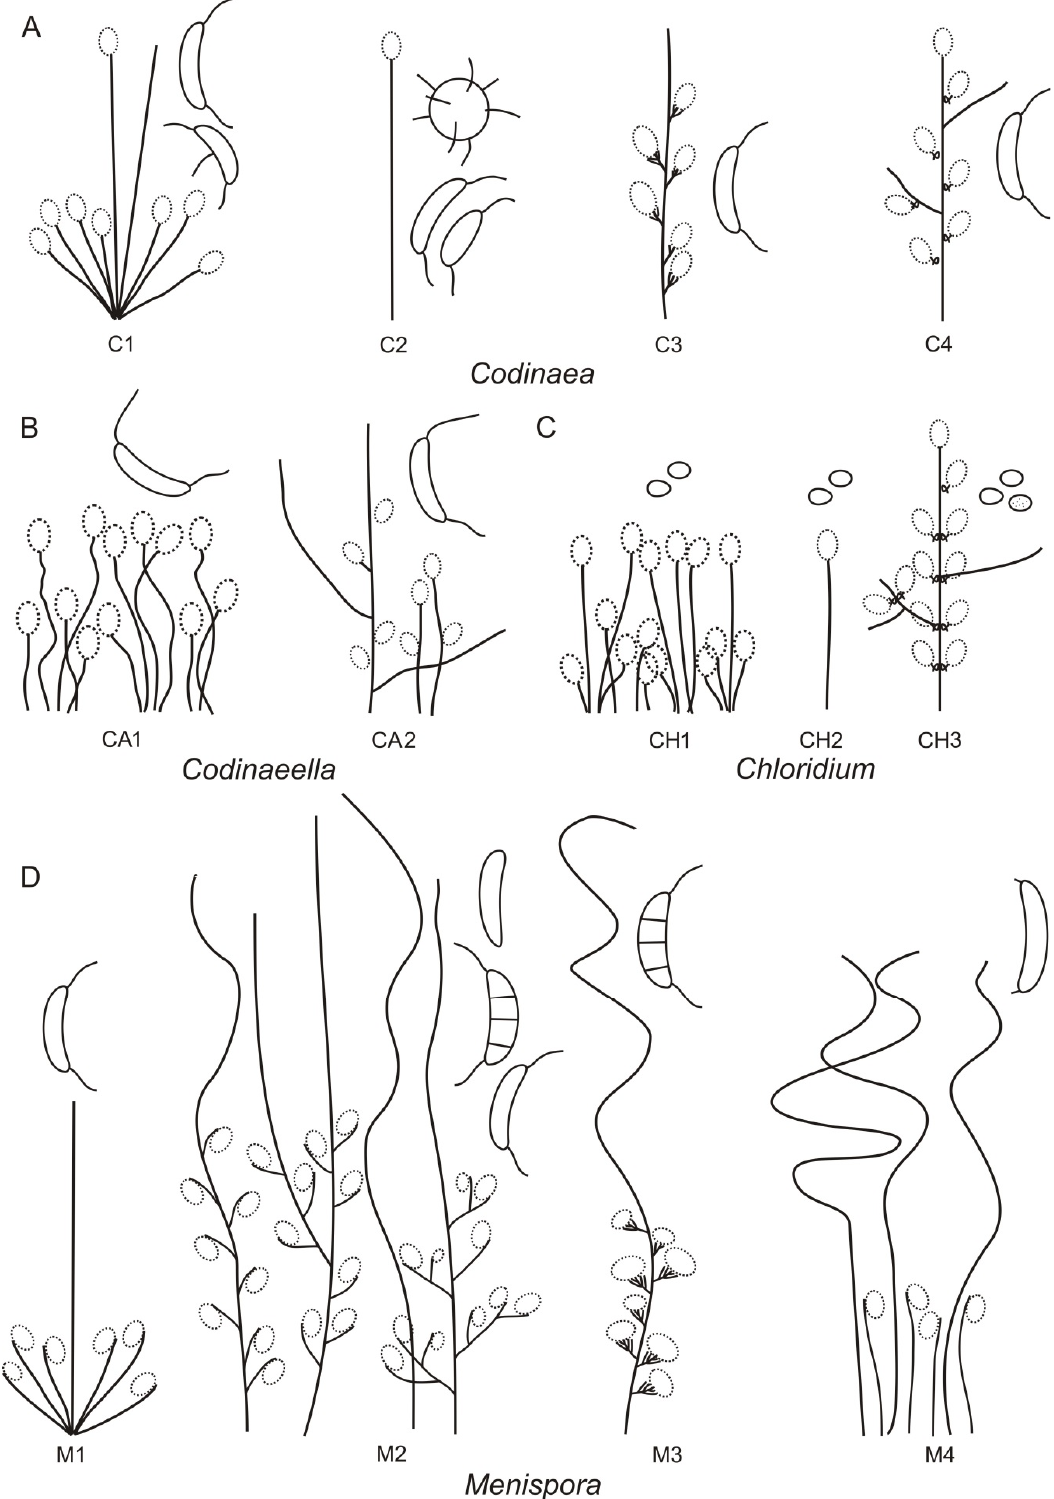
Figure 8. Illustrations of morphotypes based on the arrangement of setae, conidiophores and conidiogenous cells. ( A ) Codinaea morphotypes C1–C4 ( B ) Codinaeella morphotypes CA1–CA2 ( C ) Chloridium morphotypes CH1–CH3 ( D ) Menispora morphotypes M1–M4.